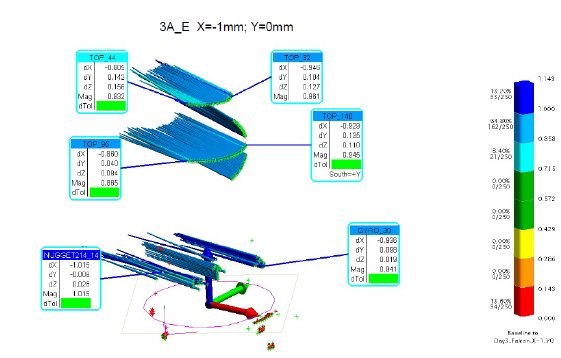
Fig. 14. Photogrammetry data obtained after a horizontal displacement of the gyrotron of 1mm in